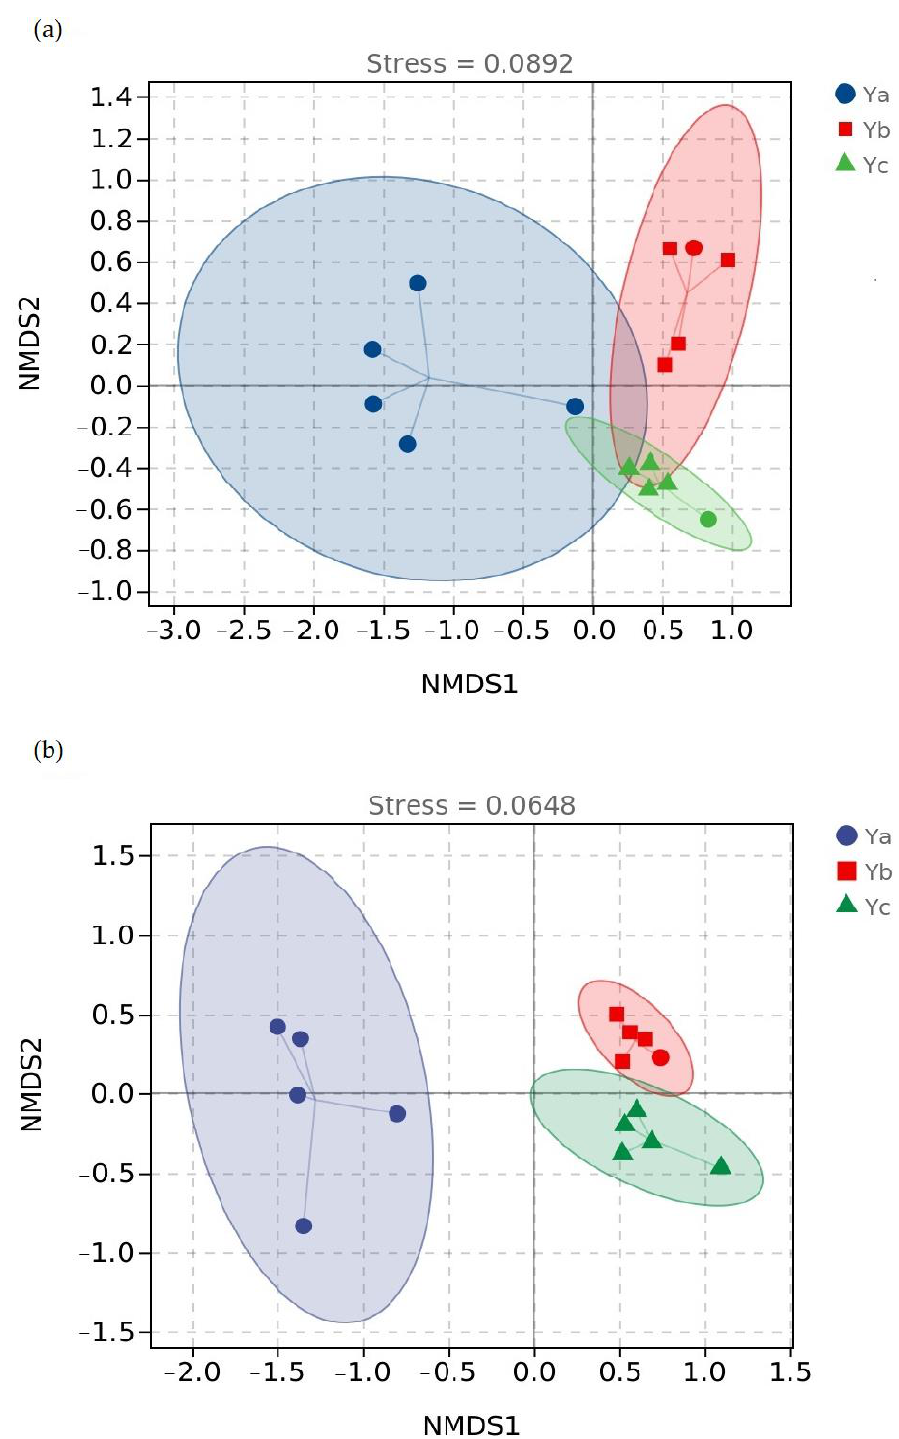
Figure 2. NMDS analysis based on Jaccard distances of phyllosphere bacterial ( A ) and fungal ( B ) community compositions among Ya, Yb, and Yc. Ya: healthy Pinus tabuliformis trees; Yb: diseased P. tabuliformis trees at an early stage of B. xylophilus infection; Yc: diseased P. tabuliformis trees in the last stage.